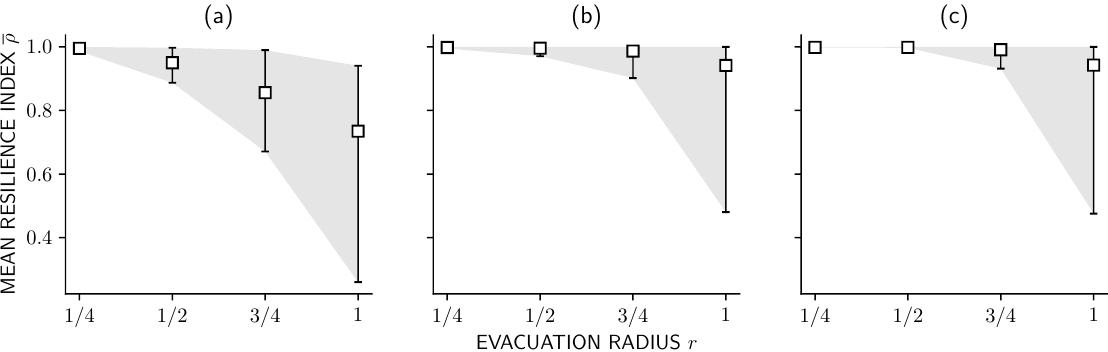
Figure 2. Mean and min-max interval resilience index ρ for evacuation radii: ( a ) centralized sheltering scheme, ( b ) near-at- hand sheltering scheme, ( c ) diffuse sheltering